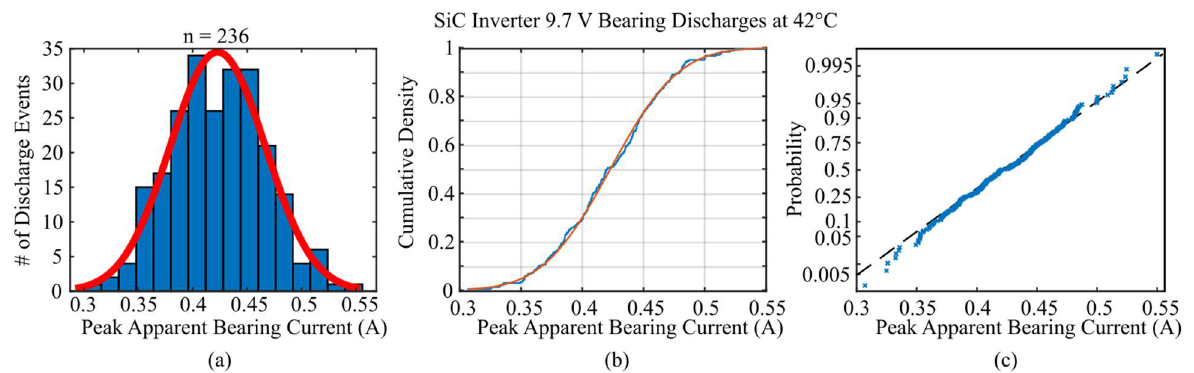
Figure 14. The resulting peak apparent bearing current follows a normal distribution for any particu-